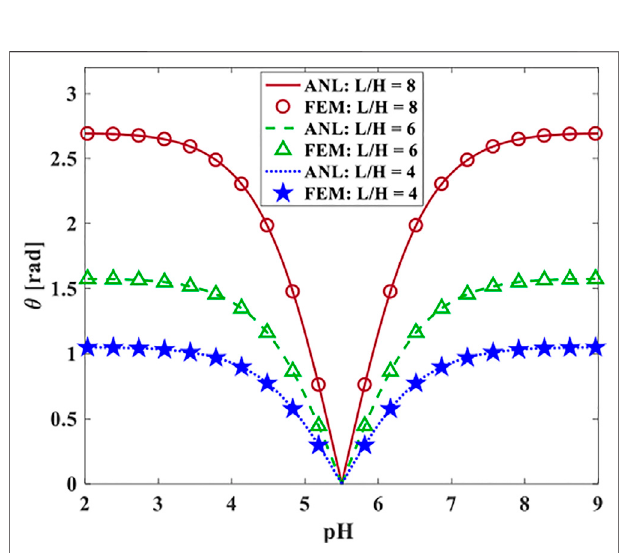
FIGURE 10 | The bending semi-angle of hydrogel with N ] (cid:1) 0 . 005 for diverseaspectratios,including L / H (cid:1) 4 , 6 , and 8inresponsetopHvariation from pH = 5.5 at reference state to higher and lower